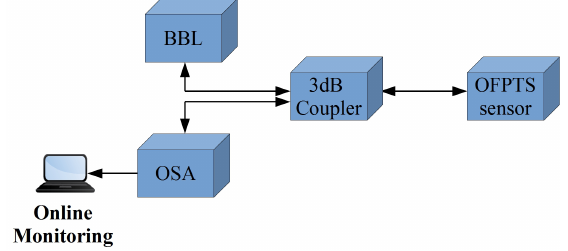
Figure 2. Schematic of the Optical